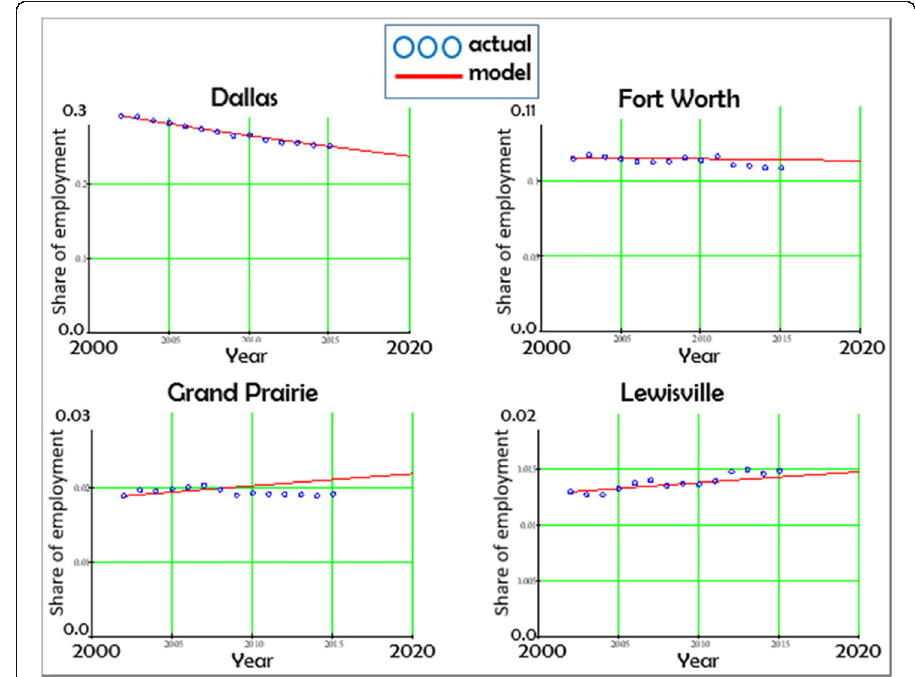
Fig. 6 Shares of total regional employment in 4 Dallas-Fort Worth cities, 2002 – 2020